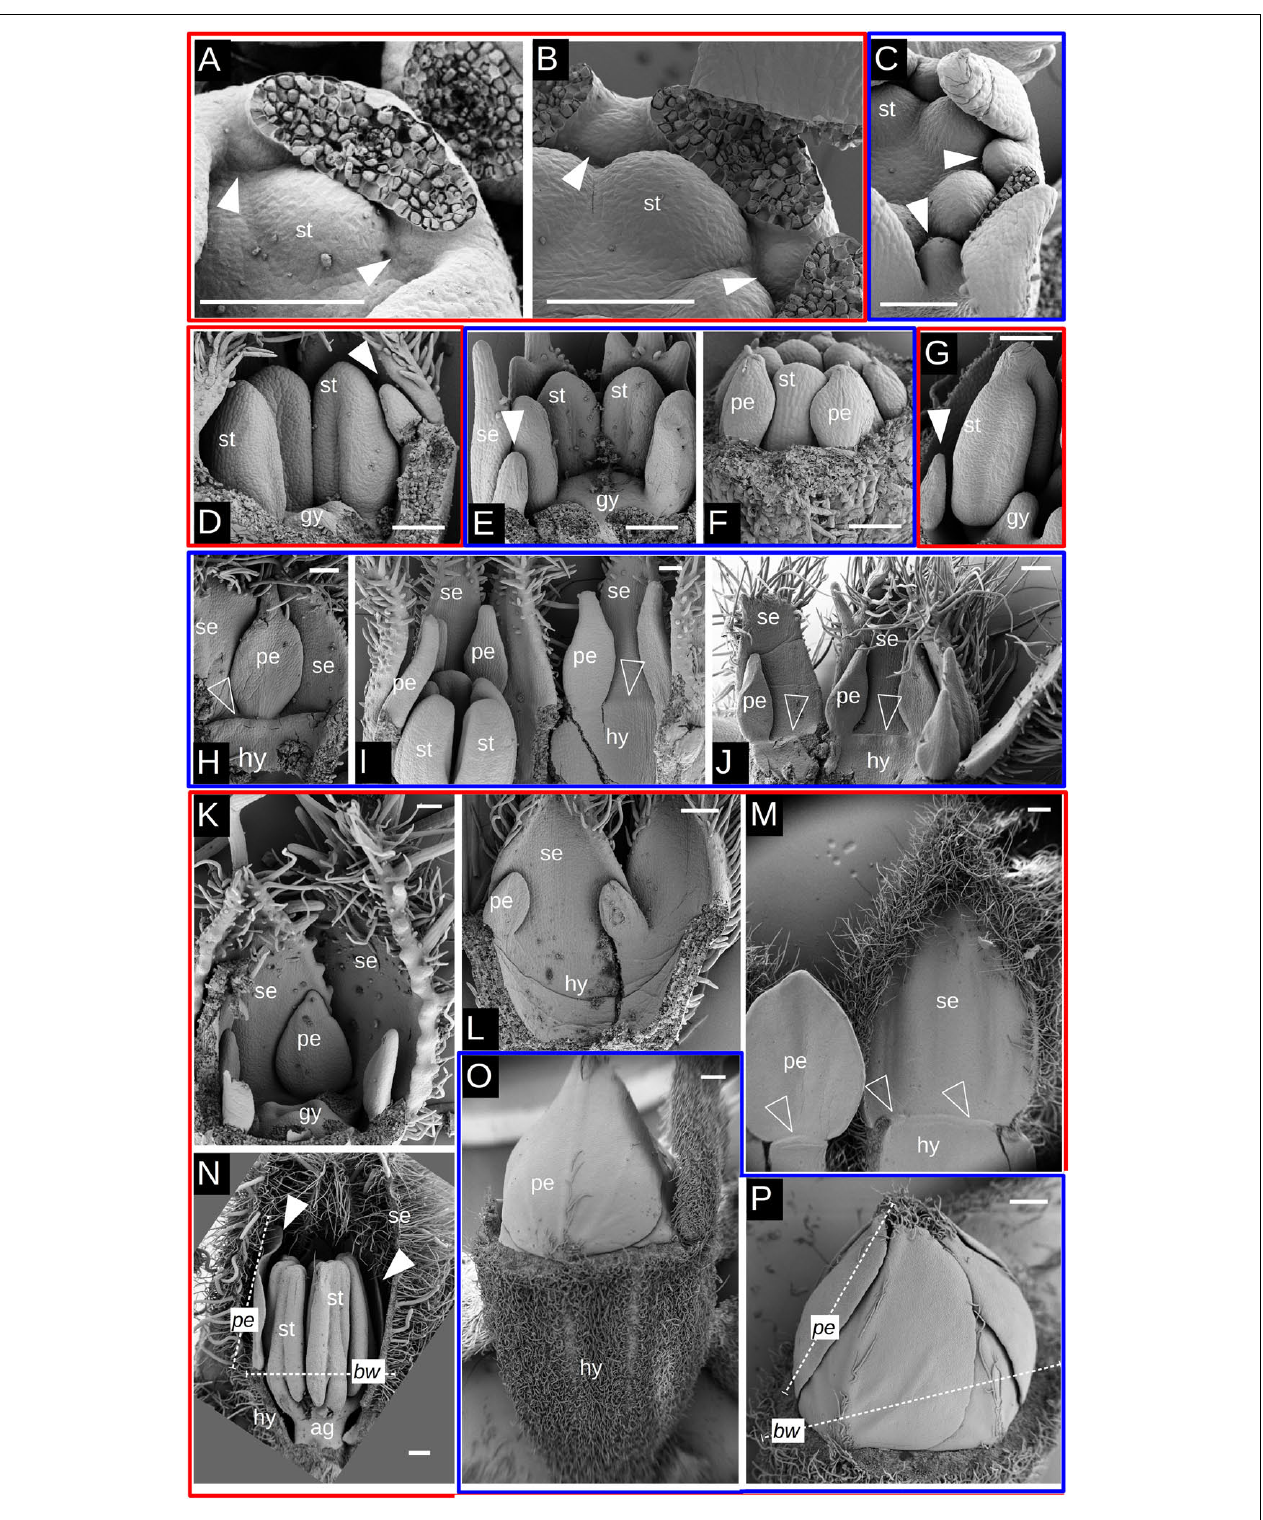
FIGURE 6 | SEM images of petal initiation and elongation in Malesherbia . Red frames surround Radiate species and blue frames Tubular species. (A) M. rugosa (Radiate) showing petal initiation (arrowheads) between stamen primordium (st) and sepals. (B) M. paniculata (Radiate) at a slightly older stage than in panel (A) showing slightly larger petal primordia. Note the position of the petal between stamens (st) and sepals. (C) M. tenuifolia (Tubular) with petal primordia placed well